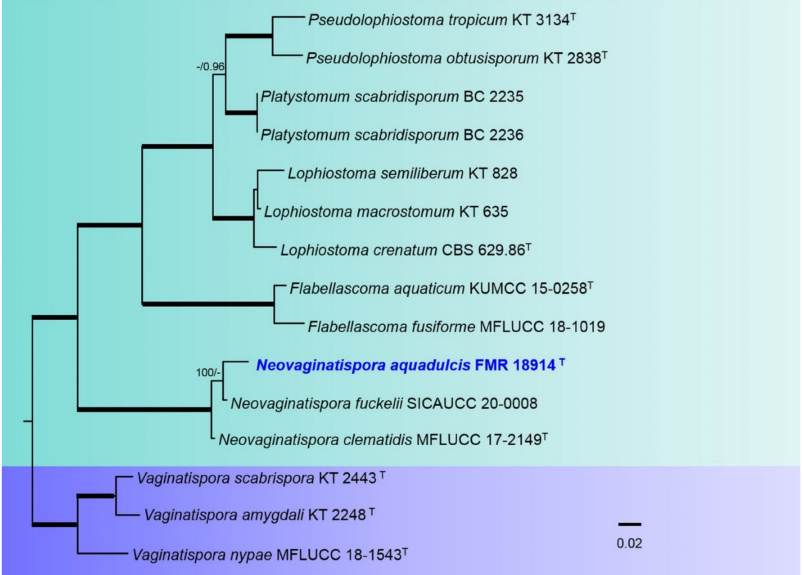
Figure 5. Phylogenetic tree inferred from an ML analysis based on a concatenated alignment of ITS, rpb2, and tef-1 sequences of 15 strains representing species in the Lophiostomataceae . The RAxML bootstrap support values (BS) above 70% and the Bayesian posterior probabilities (PP) above 0.95 are given at the nodes (BS/PP). Fully supported branches (100 BS/1 PP) are indicated in thicker lines. Newly proposed taxa are given in blue . Type strains are indicated by a superscript “T”. The tree was rooted with Vaginatispora amygdali KT 2248, V. nypae MFLUCC 18-1543, and V. scabrispora KT 2443. Alignment length 2265 bp.